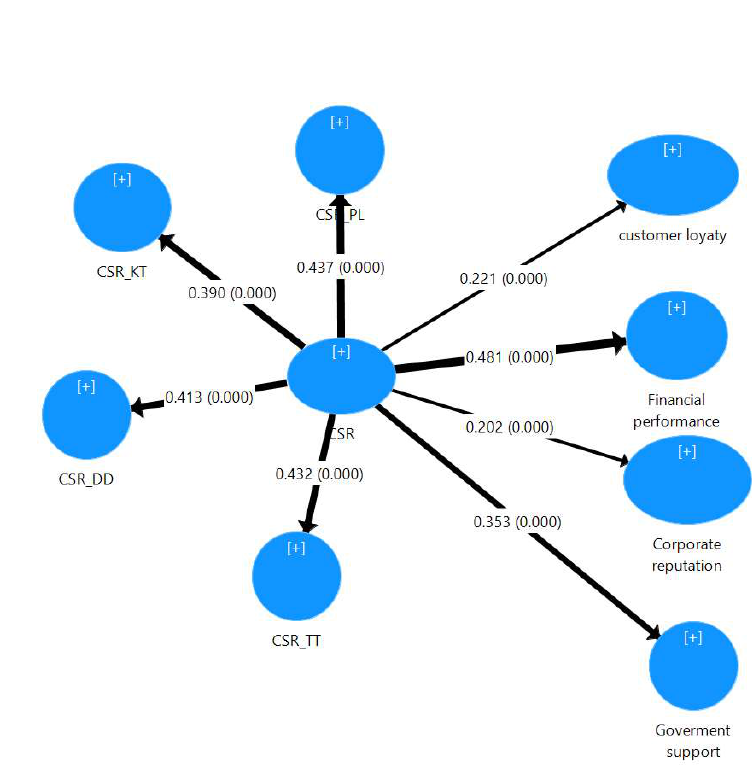
Fig. 4. Hypothesis test results